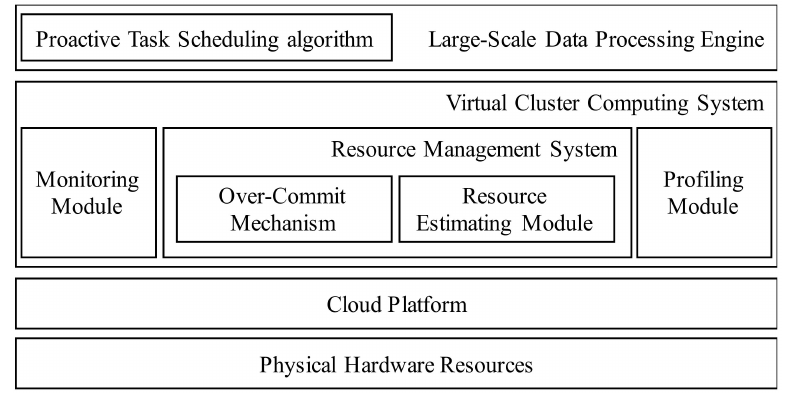
Figure 1. Proposed system